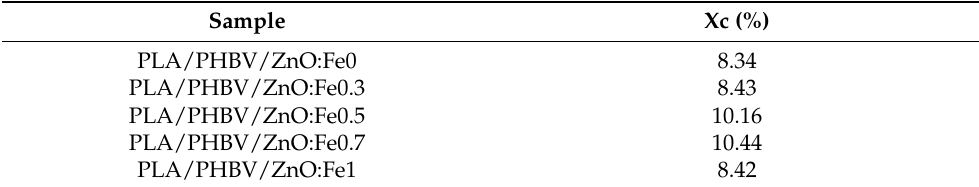
Table 3. The degree of crystallinity (Xc) for PLA/PHBV/ZnO:Fex samples.